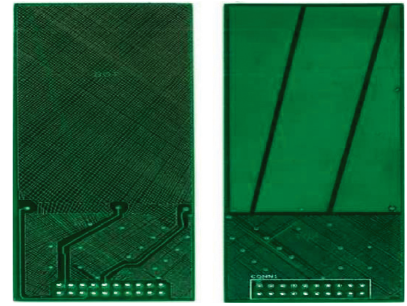
Figure 11: Fabricated PCB.